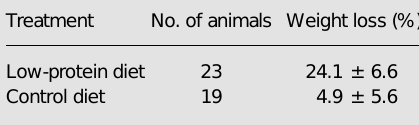
Table 1 - Effects of the low-protein and control diet on mouse body weight. Experimental mice were treated with a low-pro- tein and a control diet as described in Material and Methods. Body weight was monitored every 48 h. The results are reported as percent (mean ± SD) weight loss after 15 days of treatment. The differences in body weight at the end of treat- ment among the experimental groups were sig- nificant (P<0.0001).